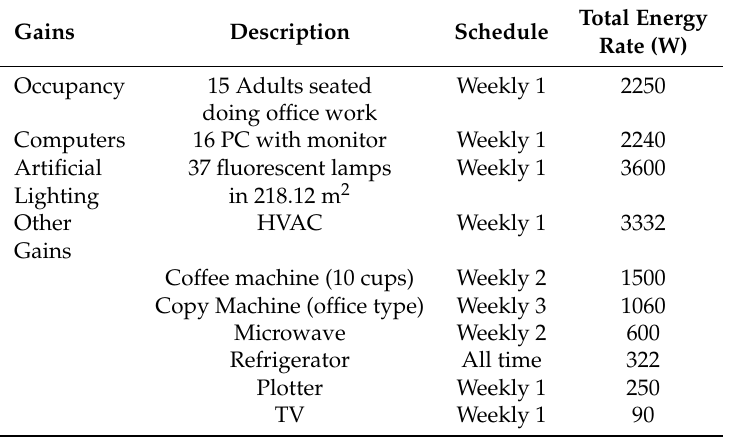
Table 3. Input data of internal gains in the AC zone on Spain case.